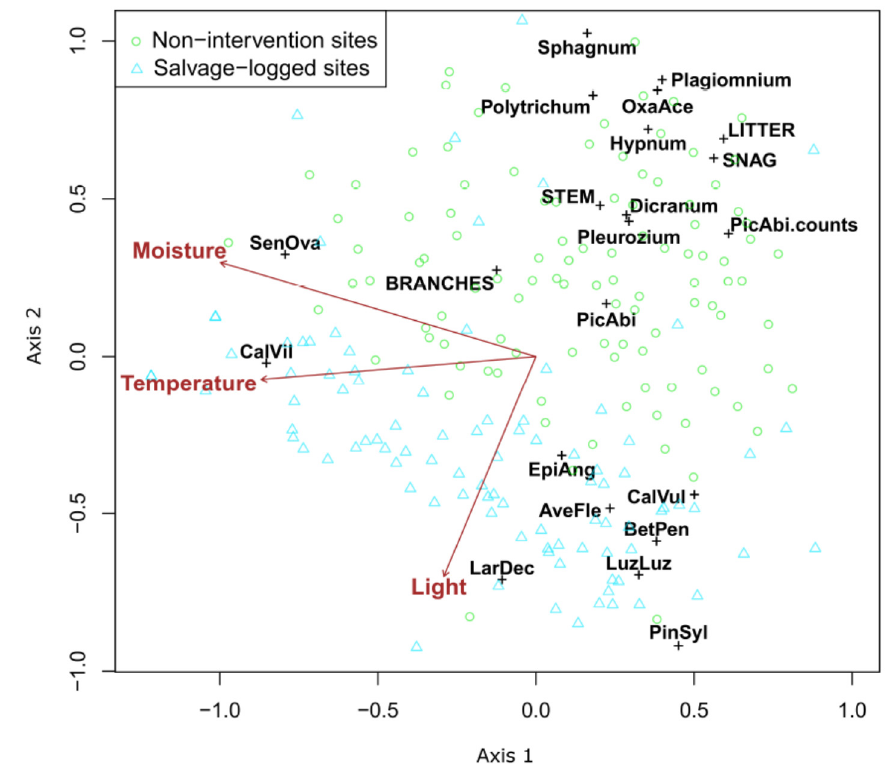
Figure 5. Non-metric multidimensional scaling (NMDS) ordination of vegetation and deadwood legacies on NI and SL sites. Vectors show passively projected Ellenberg indicator values where only those with r 2 > 0.2 and p -value < 0.001 are shown. The vector orientation shows the direction of the gradient with its length being proportional to the correlation between the variable and the ordination.